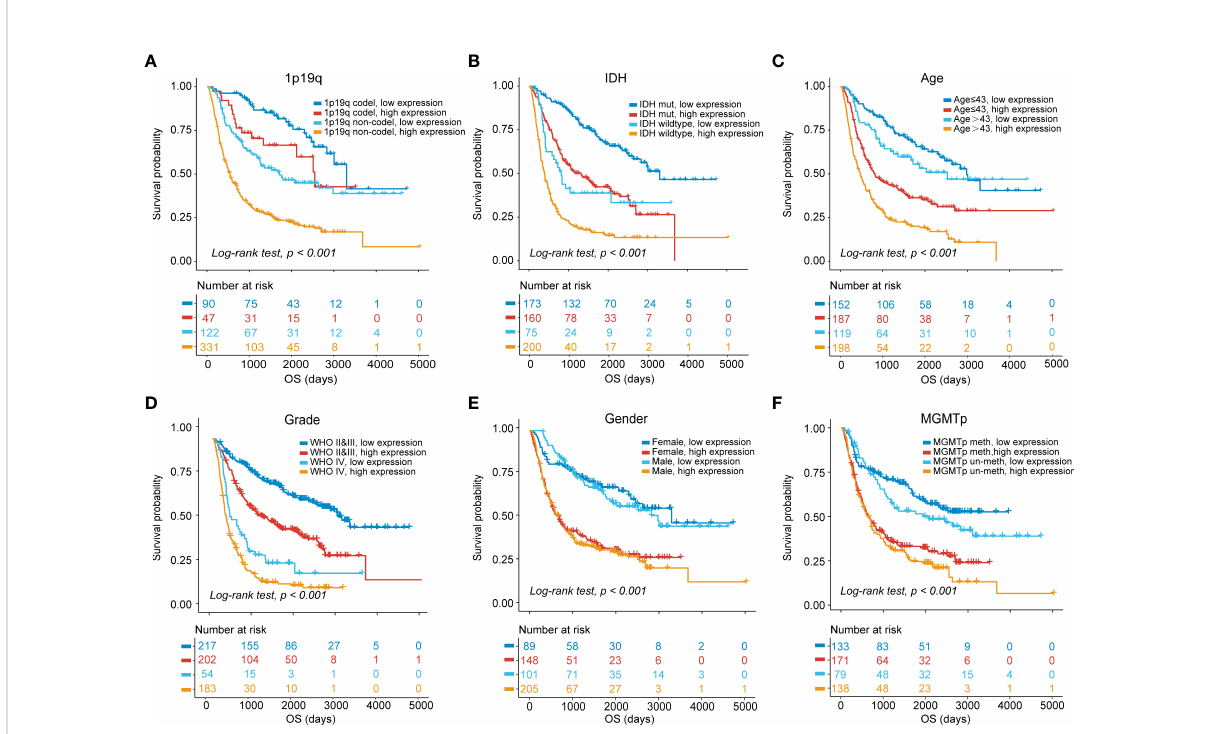
FIGURE 4 OS strati fi cation analysis.Kaplan – Meier curves of gliomas in the CGGA1 cohort based on the combined effects of MS4A6A expression and 1p19q status (A) , IDH status (B) , age (C) , grade (D) , sex (E) , and MGMTp status (F) .